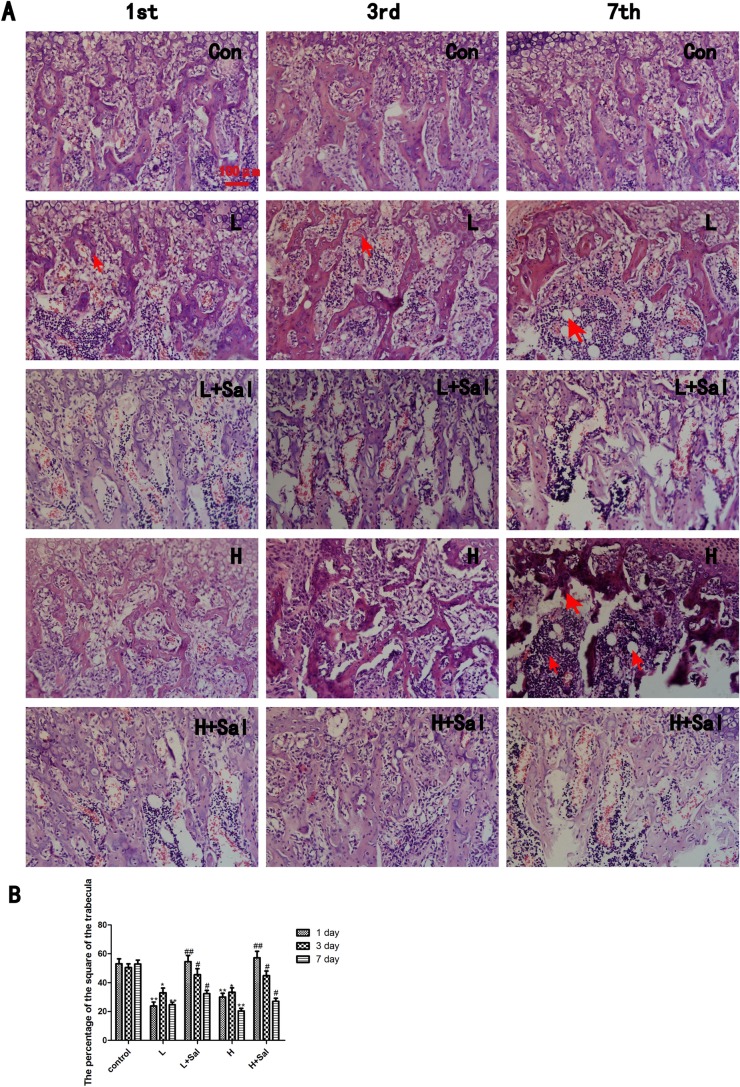
Histological examinations of subchondral bone under various compressive stresses and after injecting Salubrinal.(A) The compressive stresses caused noticeable degenerative changes, including irregular changes to the order and morphology of the bone trabeculae and pathologic changes and inflammation in the heavy compressive stress group. Resorption of the trabeculae is indicated (arrow) in the 1-day and 3-day light compressive subgroups. Vacuole and inflammatory cells are indicated (arrow) in the 7-day compressive subgroup. After the Salubrinal injection, the trabeculae widths recovered. Vacuoles were not observed, and the trabeculae were continuous. In addition, inflammatory cells decreased. (B) The quantitative changes in the percentage of the area of the bone trabeculae. Scale bars, 100 μm. (* indicates the comparison between the compressive stress groups and the control group, * p<0.05, ** p<0.01; # indicates the comparison between the Sal/compressive stress groups and the compressive stress groups, # p<0.05 ## p<0.01).